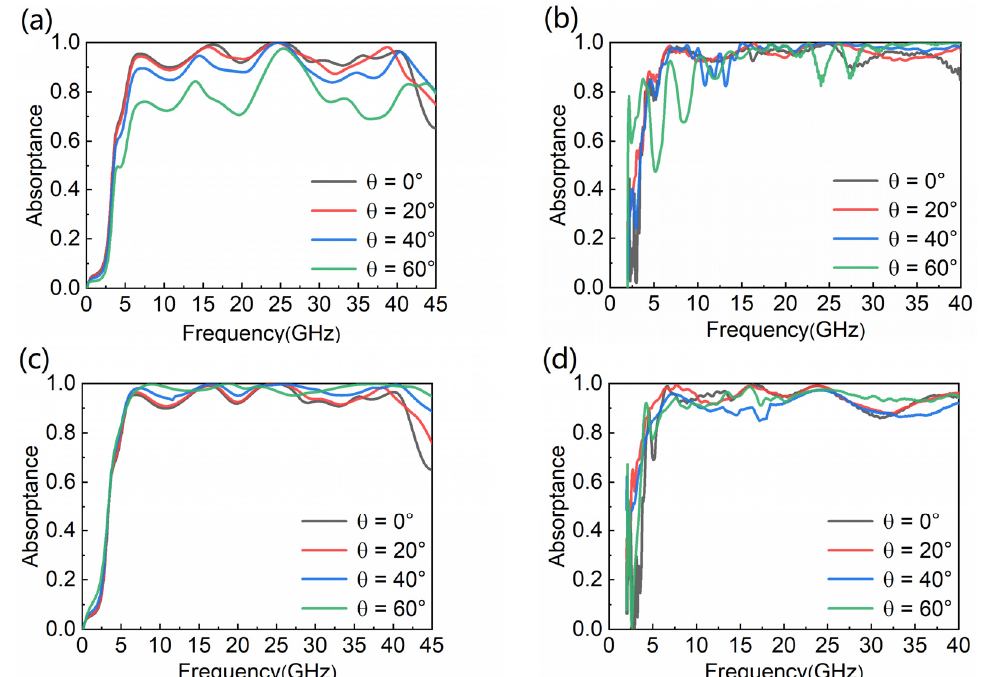
Figure 4. Absorptance of simulation and experiment at different angles of incidence: ( a , b ) TE mode; ( c , d ) TM mode.